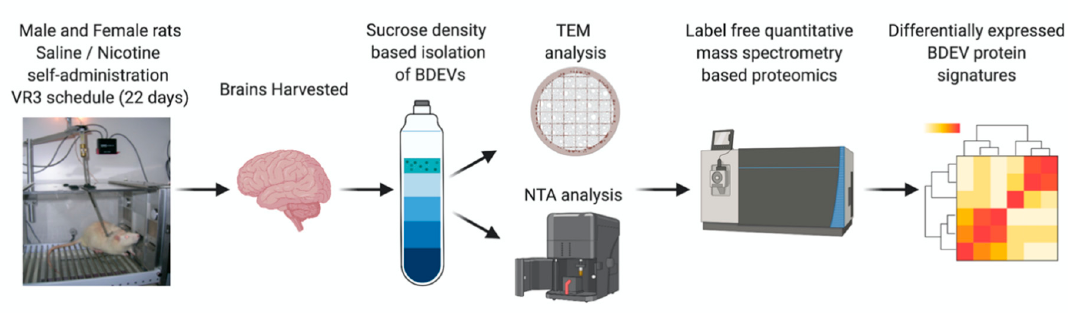
Figure 1. Scheme of experimental in vivo design . A visual representation of the experimental process beginning with nicotine self-administration followed by brain isolation, EV extraction, and proteomics analysis.